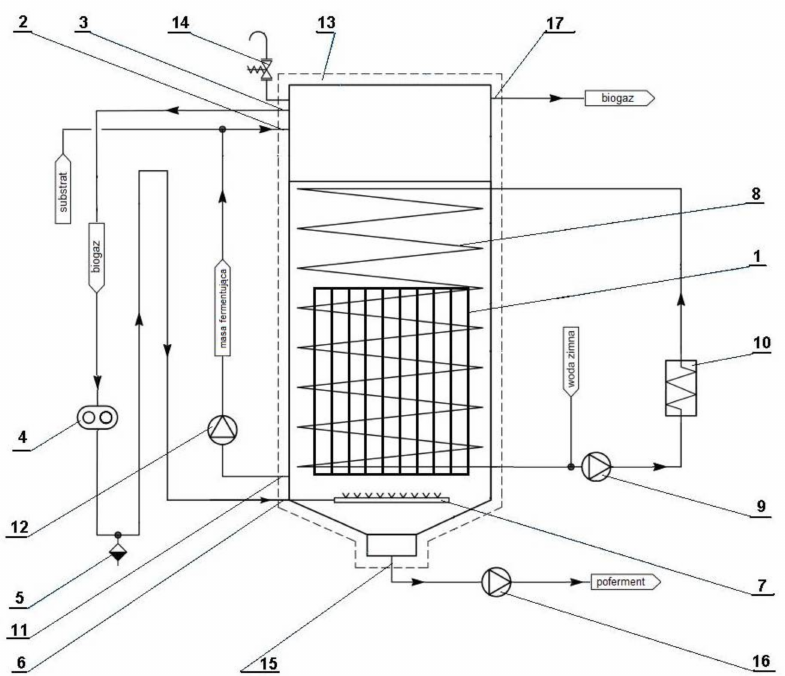
Figure 2. The schematic diagram of the fermenter [53]: 1—pipe, 2—stub pipe, 3—biogas outlet stub device), 8—heating coil, 9—water pump, 10—heat exchanger, 11—fermenting mass outlet stub pipe,